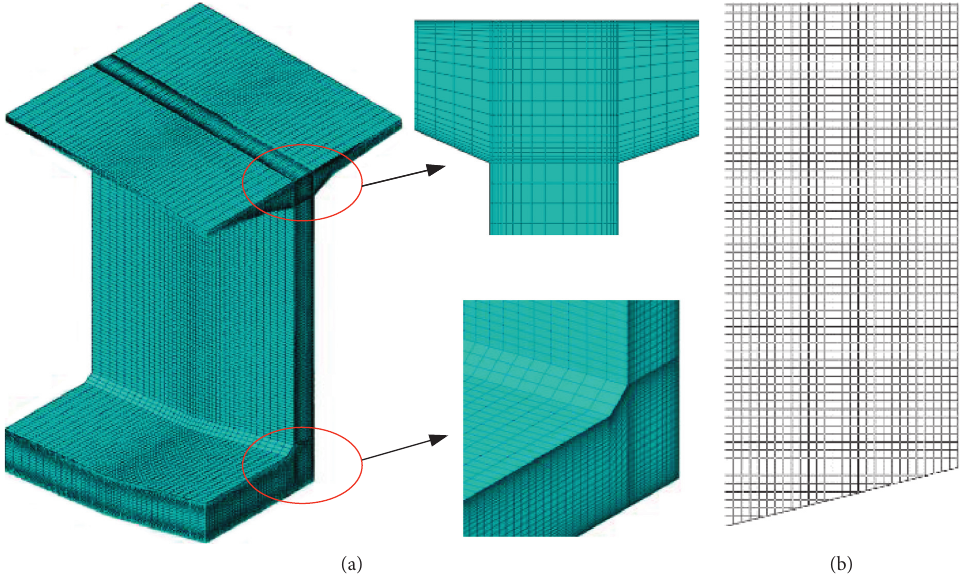
Figure 14: The finite element mesh model. (a) Concrete elements. (b) Rebar